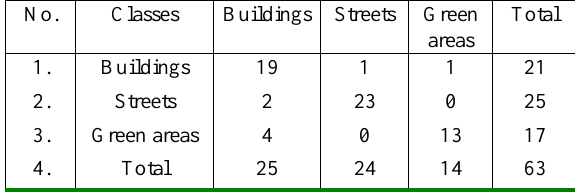
Table 1 . Matrix for the image from 2021